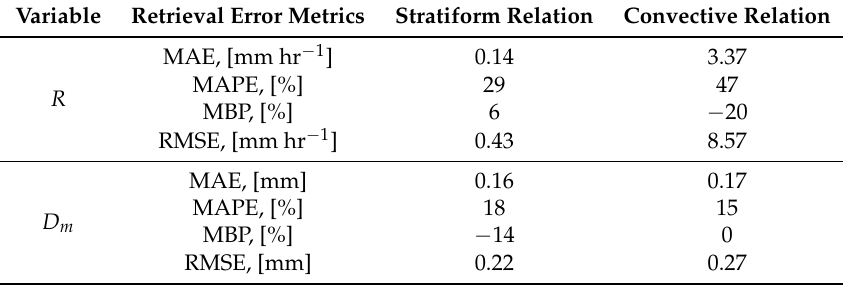
Figure 4. Convective–stratiform partitioning based on PSD parameters. ( a ) Normalized intercept parameter ( N w ) median volume diameter ( D 0 ) plane of all raining PSDs. The red points are labeled as convective and blue are labeled as stratiform based on the classification in [78]. The polygons from [78] are drawn in solid blue (stratiform) and dashed red (convective). ( b ) Same as Figure 3a, but with the separated categories. Red is convective, blue is stratiform. The lighter the color, the higher the density of points. ( c ) Same as Figure 3b, but with the separated categories. Colors are the same as ( b ). Table 3. Error metrics for the 2DVD data after classifying the PSD data based on the values of N w , D 0 and